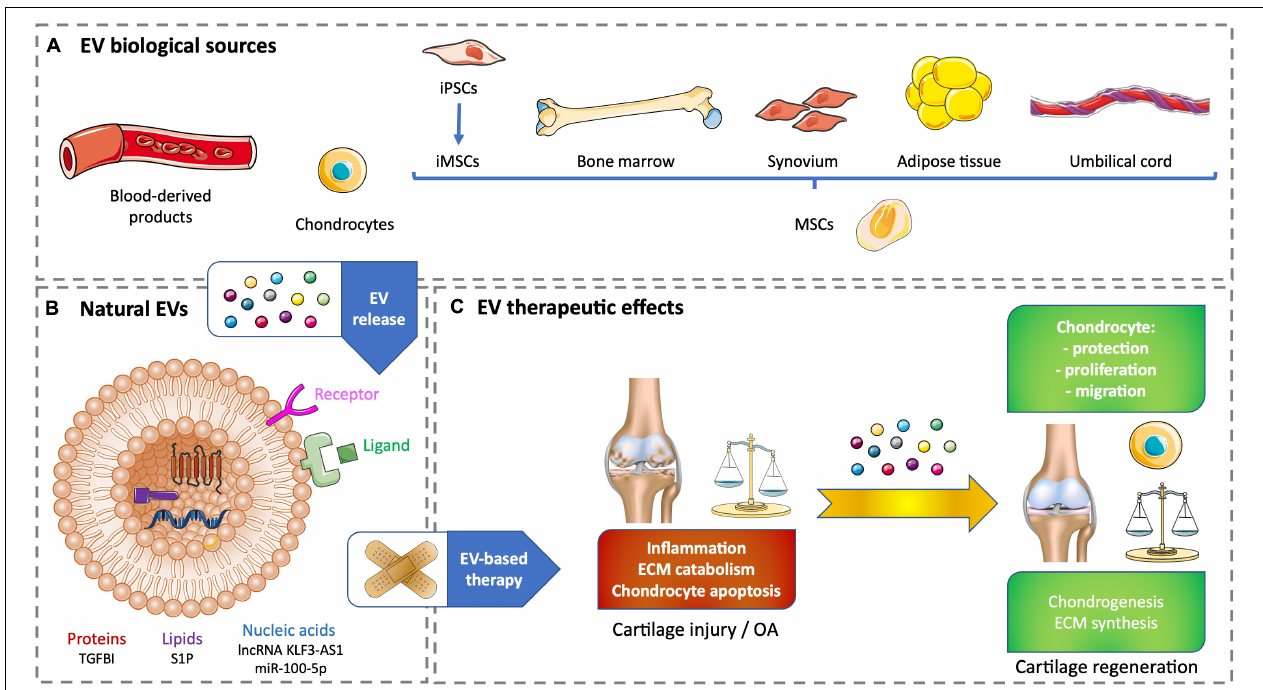
FIGURE 1 | Therapeutic effects of natural EV-based therapy for cartilage healing. (A) Various cell sources for generating non-modified EVs. (B) Example of therapeutic cargos for natural EVs conveying proteins (TGFBI), nucleic acids (lnc KLF3-AS1, miR-100-5p), or lipids (SP1). (C) EV therapeutic effects on cartilage injury or OA. ECM, extracellular matrix; EV, extracellular vesicle; iPSC, induced pluripotent stem cell; iMSC, induced pluripotent stem cell-derived mesenchymal stem cell; lncRNA, long non-coding RNA; miR, microRNA; MSC, mesenchymal stem cell; OA, osteoarthritis; S1P, sphingosine-1-phosphate; TGFBI, transforming growth factor β –induced